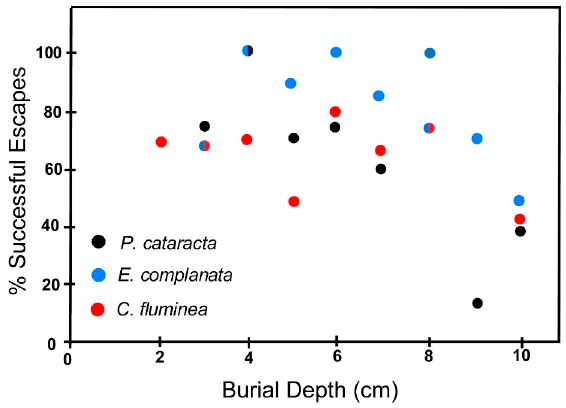
Elliptio complanata ; COR— Corbicula fluminea. In columns 2–4, the number to the left of the comma in